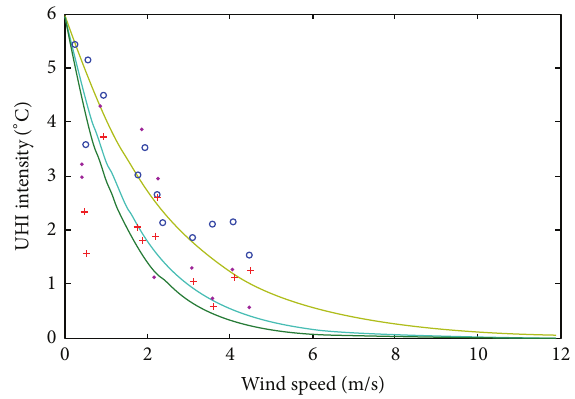
Figure 5: The effect of the wind speed on the UHI intensity in Chambly, Marieville, and St. Basile-Le Grand.